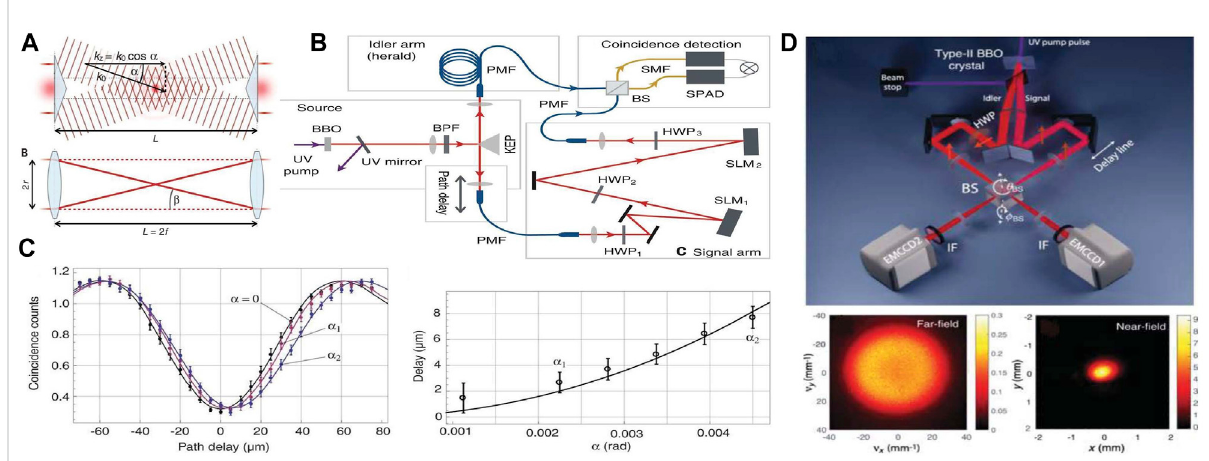
FIGURE 2 (A) Bessel beam can be created with an axicon, producing conical phase fronts of angle α . A ray entering a confocal telescope at radius r will travelanadditionaldistanceproportionaltocos − 1 β . (B) Experimentalsetupformeasuringthetimedelayarisingfromspatiallystructureofphotonsby usingaultra-preciseHOMinterferometry. (C) ExperimentalobservationofthetimedelayforaBesselbeam.Fromref.[24].Reprintedwithpermission from AAAS. (D) Experimental setup for imaging spatiotemporal biphoton states with a HOM interferometer. Reprinted with permission